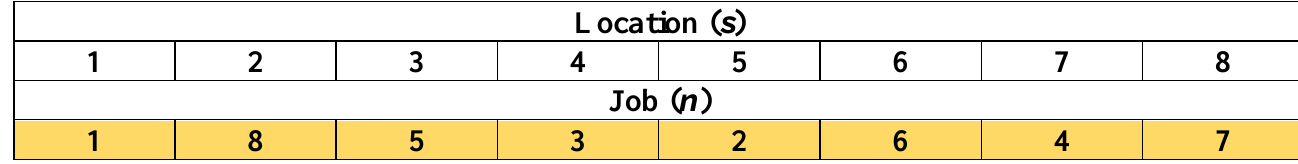
Figure 9. A typical solution representation for